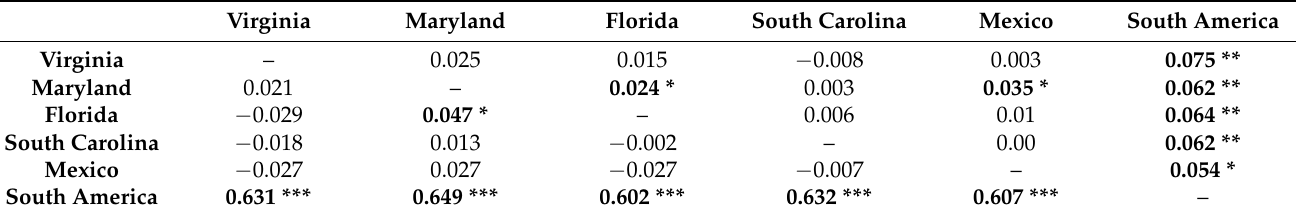
Table 2. Pairwise comparisons of genetic differentiation, in American populations of Callinectes sapidus , estimated from nucleotide divergence ( Φ ST , below the diagonal) and haplotype frequency ( F ST , above the diagonal). Significant values in bold (*: p < 0.05; **: p < 0.01; ***: p < 0.001) were calculated from 10,000 permutations. Virginia N = 18, Maryland N = 19, Florida N = 13, South Carolina N = 18, Mexico N = 10, South America N = 17.